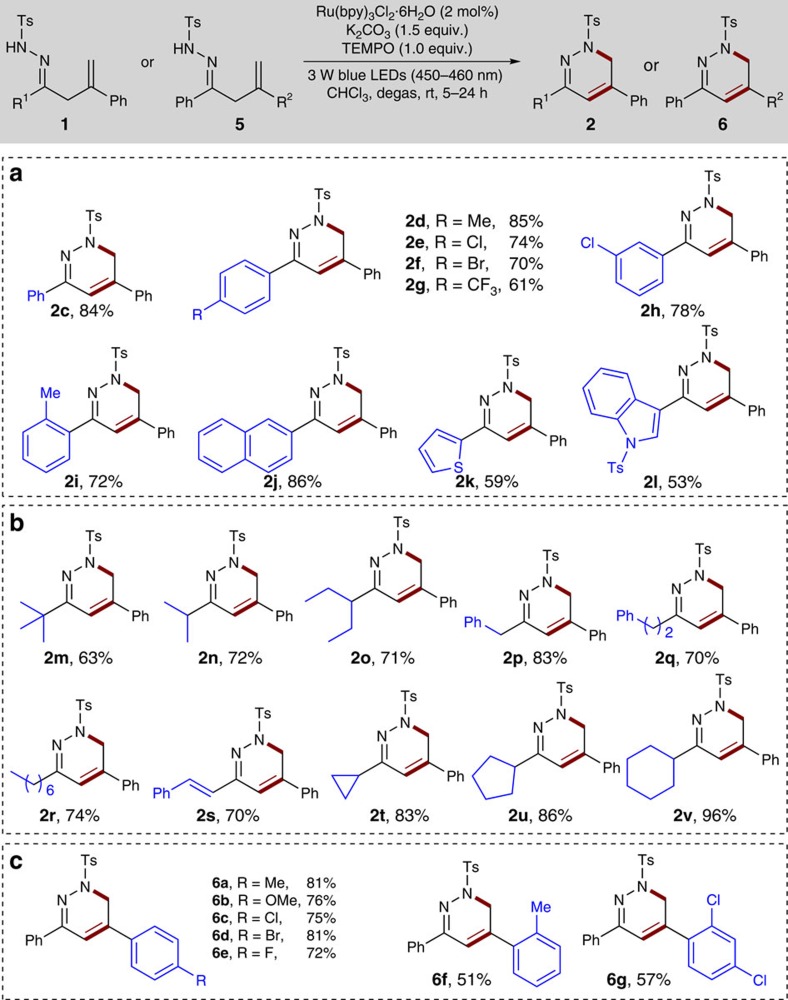
Reaction scope of unsaturated hydrazones.(a) Investigation of the effects of arene substitution of hydrazones. (b) Substrate scope of aliphatic unsaturated hydrazones. (c) Substrate scope of alkene moieties. Unless otherwise noted, reactions were run with 1 or 5 (0.3mmol), Ru(bpy)3Cl2·6H2O (0.006mmol, 2.0mol%), K2CO3 (0.45mmol), TEMPO (0.3mmol) and CHCl3 (6.0ml) at rt for 5–24 h under irradiation with 3 W blue light-emitting diodes (450–460 nm).